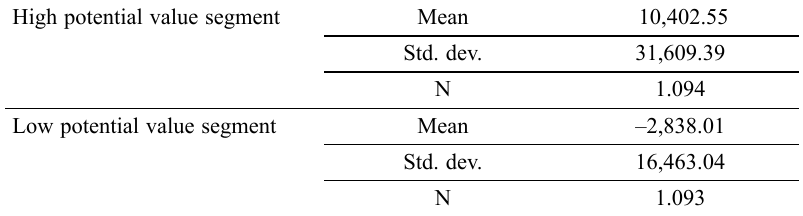
Table 6. Ex-post segmentation based on CPV (descriptive statistics calculated for CPV) High potential value segment Mean